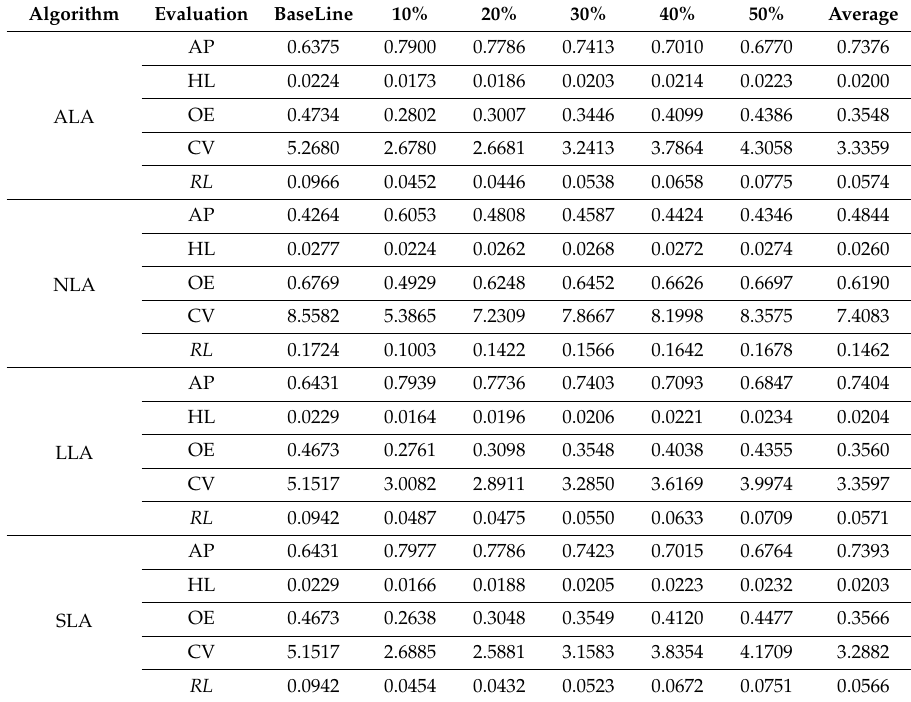
Table 3. Experimental results on Medical data set.